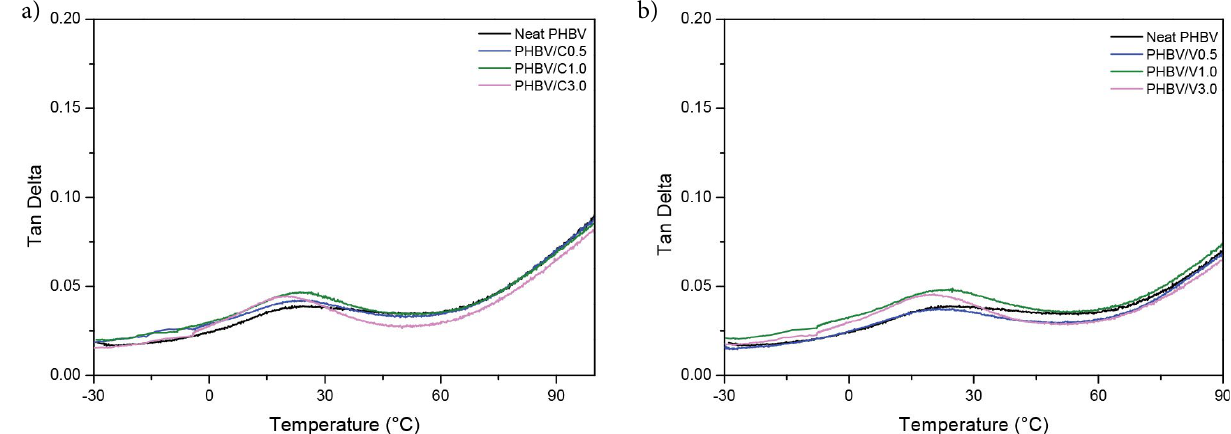
Figure 11. DMA thermographs showing tan delta for PHBV/CaCO 3 composites with (a) calcite and (b)